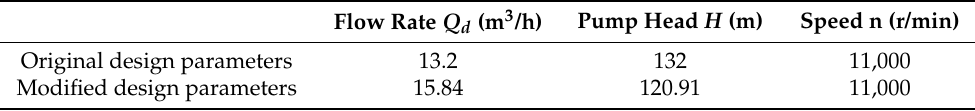
Table 1. Design parameters of the aeronautic cooling pump.